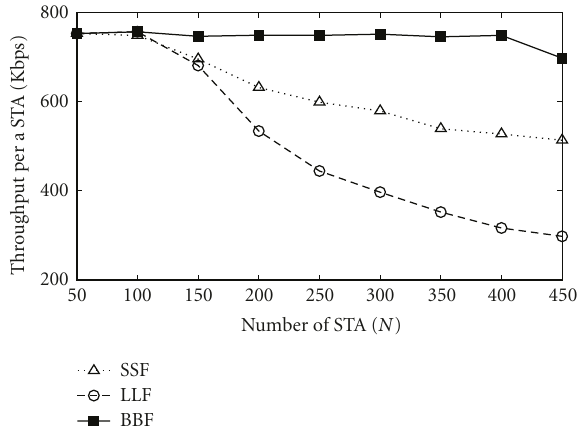
Figure 13: Average throughput per an STA.